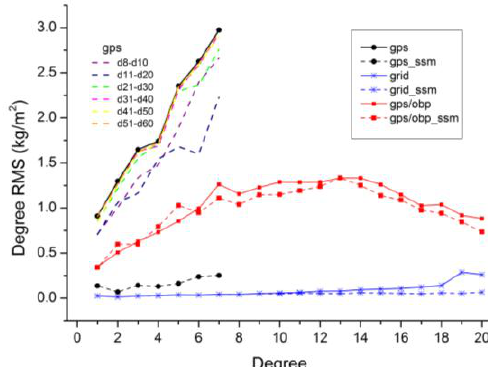
Figure 5. The degree RMS differences between low-degree estimates from various inversion schemes and reference values discussed in Section 2.1. Simulated GPS displacements (‘gps’), global 5° × 5° grids (‘grid’) and GPS/OBP (‘gps/obp’) are used. Solid lines and dashed lines denote the degree RMS differences before and after removing the aliasing errors, respectively. Dashed lines without symbols denote the degree RMS differences after removing the cumulative aliasing errors of d8–d10, d11–d20, d21–d30, d31–d40, d41–d50 and d51–d60 from GPS inversion, respectively. Sensors 2016 , 16 , 679